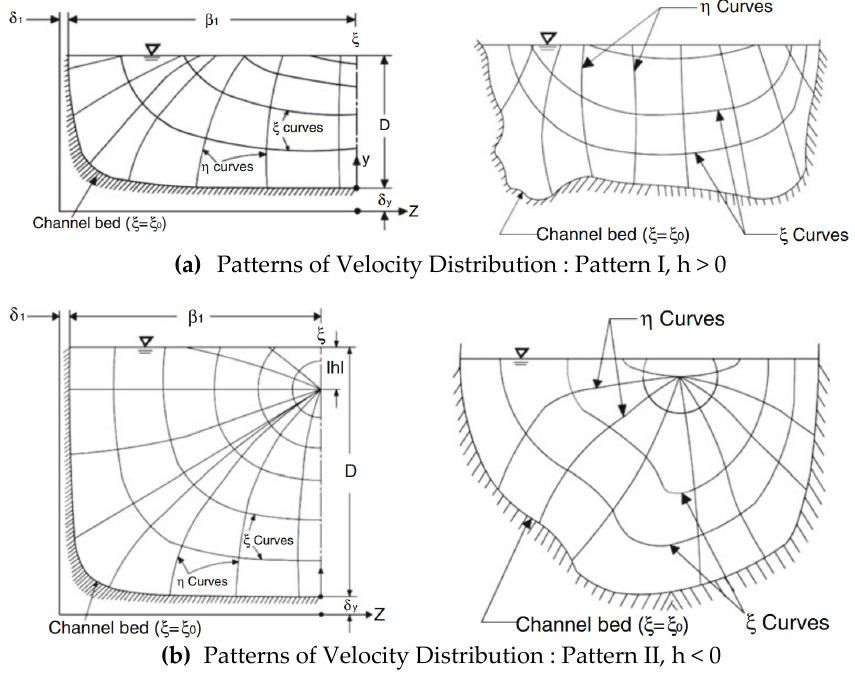
Figure 2. (cid:2022) - (cid:2015) of an open-channel flow (Chiu [12,13]). Figure 2. ξ - η of an open-channel flow (Chiu